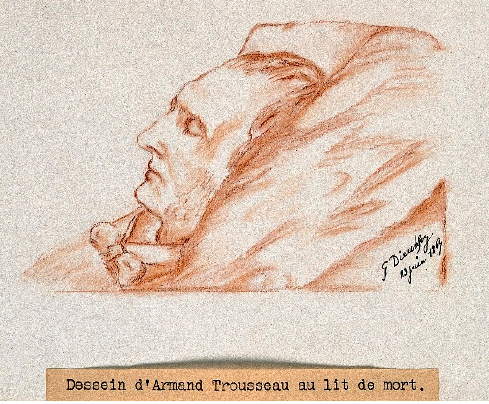
Figure 1. A chalk drawing of Trousseau on his deathbed by one of his students, Dieulafoy G.